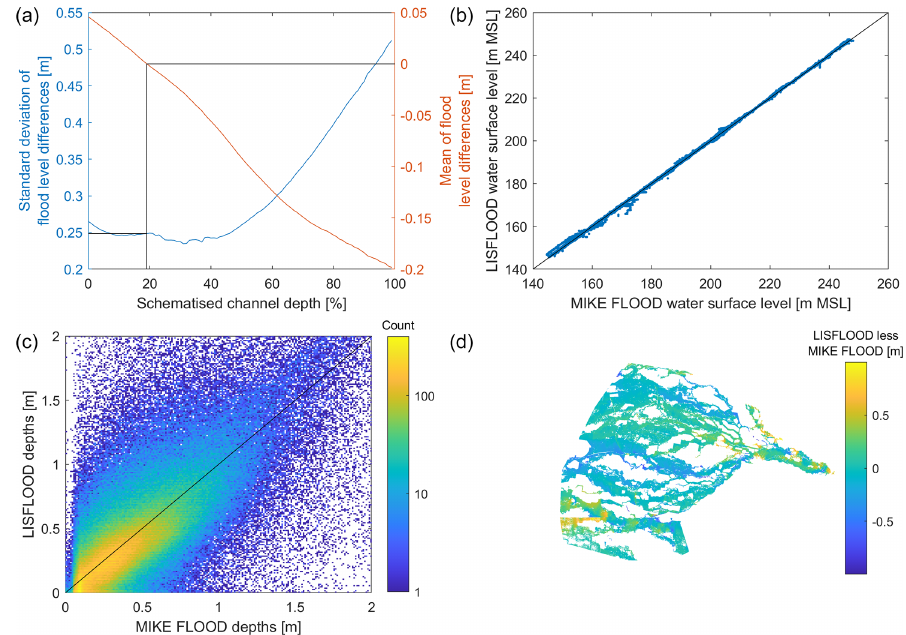
Figure 5. Gwydir River hydraulic model (LISFLOOD) calibration to existing MIKE FLOOD hydraulic models by NSW Environment & Heritage. (a) Selection of schematized channel depth (zero means no channels and 100% means largest main channels possible from survey) with the black lines showing selected channel depth. (b) A comparison between flood levels across the entire model (blue dots) with perfect fit (black line). (c) A comparison between flood depth across the entire model. (d) Difference map between